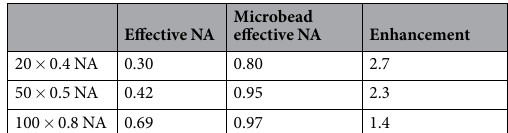
Table 1. Characterization of the effective NA of the different objectives used (10% MTF criterion), and the effective NA when imaging through the microbead. The resolution enhancement is also included.